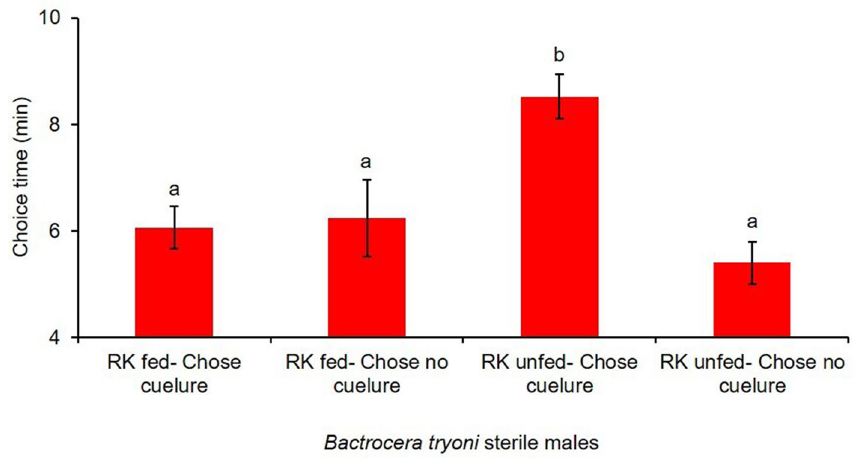
Figure 3. Time required by RK fed and RK unfed sterile male B. tryoni to make a choice inside the Y-tube olfactometer when exposed to cuelure. Lowercase letters on each column that differ are significantly different (p <